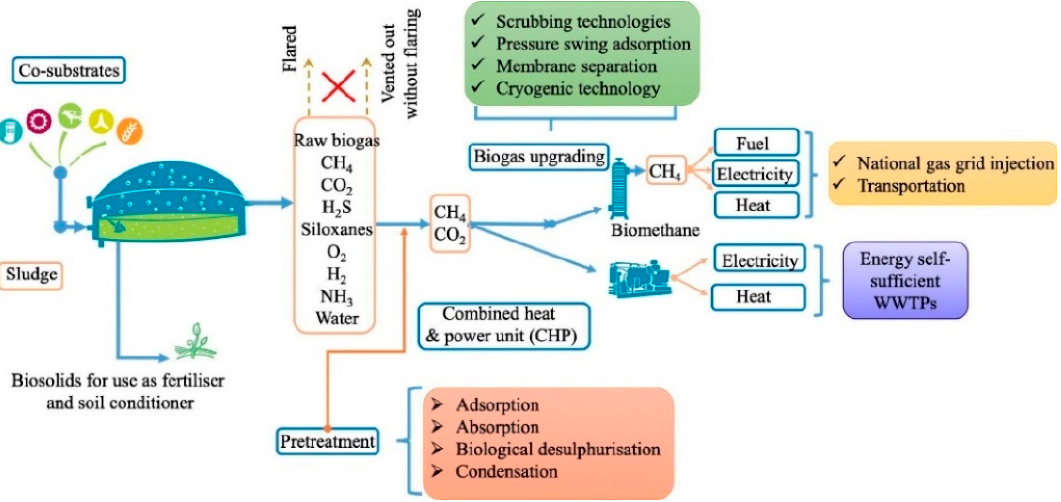
Figure 2. Anaerobic Digestion Scheme: a representation of the material flows from biowaste recovery to biogas application. Reproduced with permission from [23]; published by Elsevier, 2021.